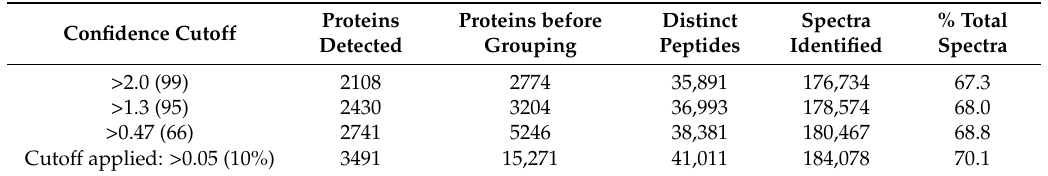
Table 1. Number of proteins and peptides identified by ProteinPilot after iTRAQ LC/MS/MS analysis of human adipose derived stem cells (hADSCs), S -aminoethyl- L -cysteine ketamine (AECK) differentiated, LK differentiated and Glioblastoma cells. Confidence cutoffs are the proteins with significant change detected between